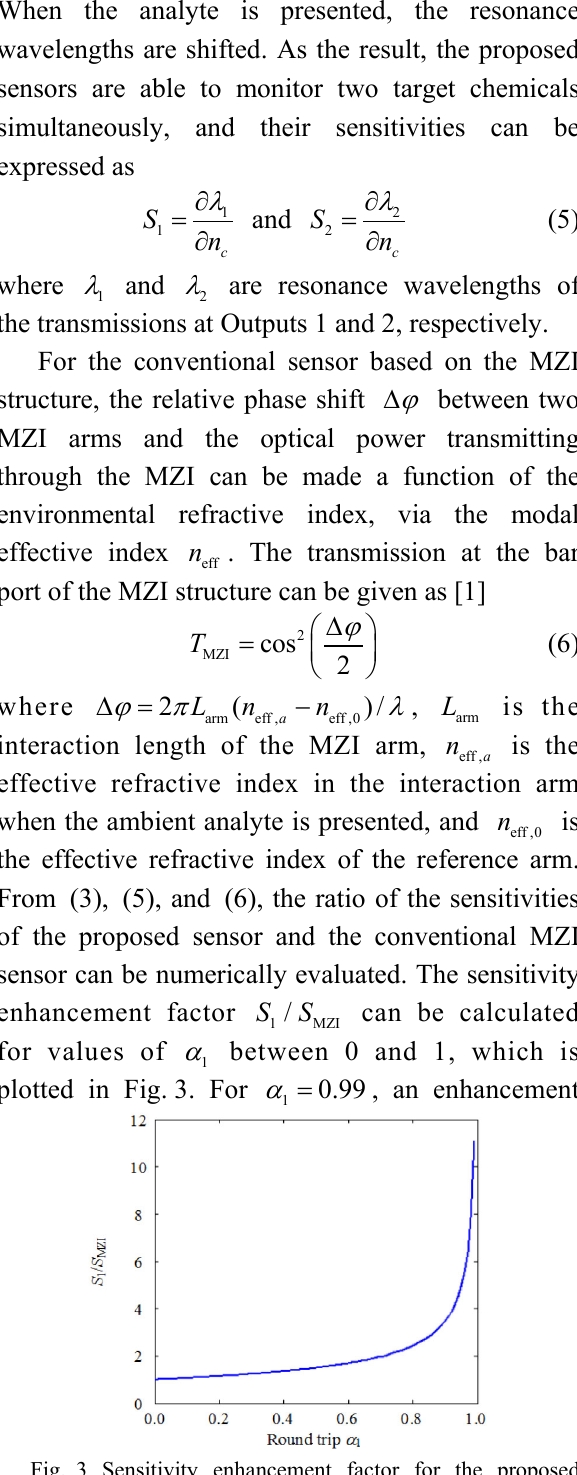
Fig. 4 Refractive indexes of the glucose and ethanol verus